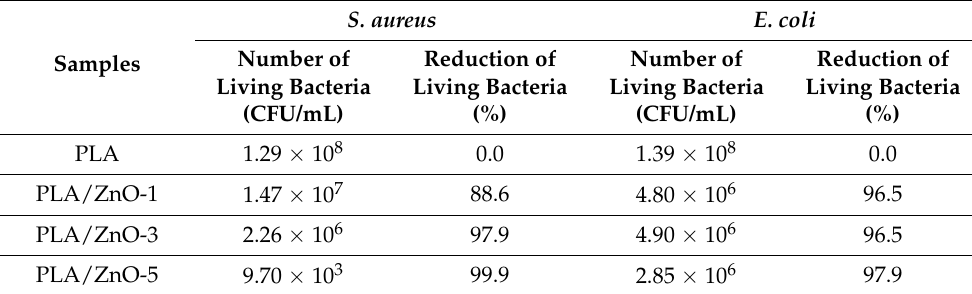
Figure 8. Inhibition zones of antibacterial activities of neat PLA and PLA/ZnO biocomposite filaments. Table 3. Antibacterial efficacies of PLA/ZnO composite filaments.